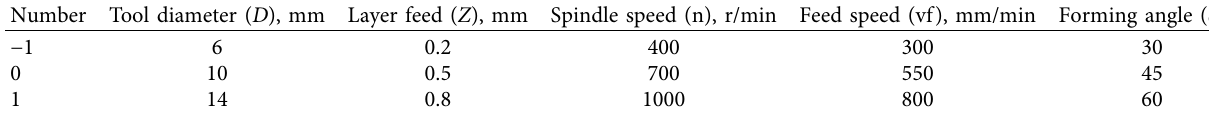
Table 2: Factors and levels of BBD design.